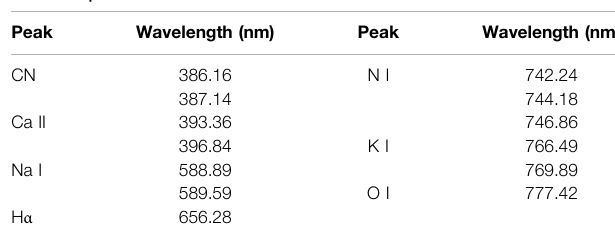
TABLE 3 | Thirteen lines selected to construct SVM